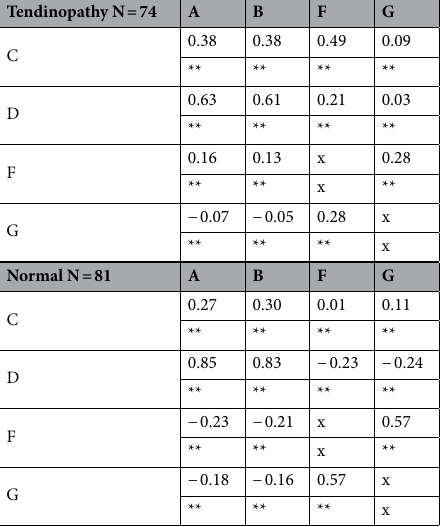
Table 5. Pearson correlation coefficients between diameters of the Achilles tendon, p < .05 marked as *, p < .001 marked as **. A, B, C, D, F, G—dimensions of the Achilles tendon defined in the Material and